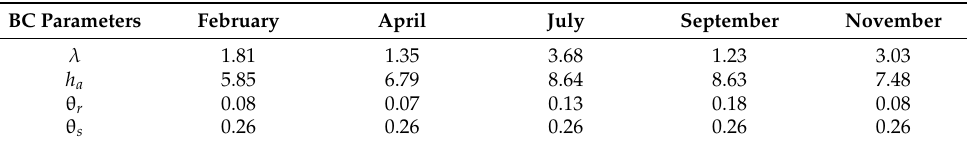
Table 2. The estimated relative parameter of Brooks–Corey from the time-lapse ERI survey at the PT06 site for five different months of 2019.